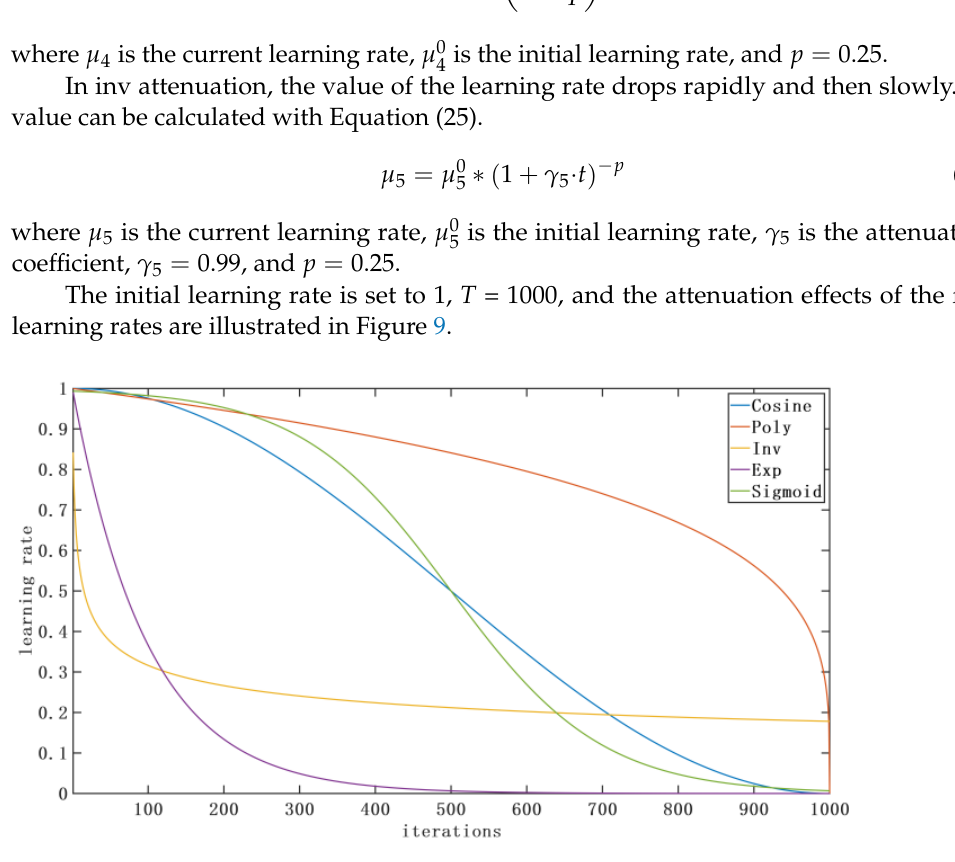
and 𝜑 . The training algebra is set to 500. In 0 0